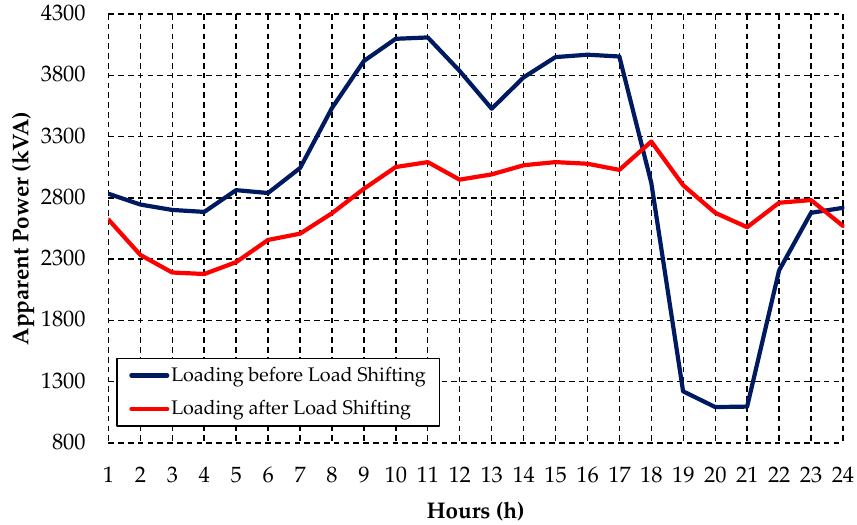
Figure 15. Rural Feeder A loading before and after load shifting of irrigator customers. Source: The authors.